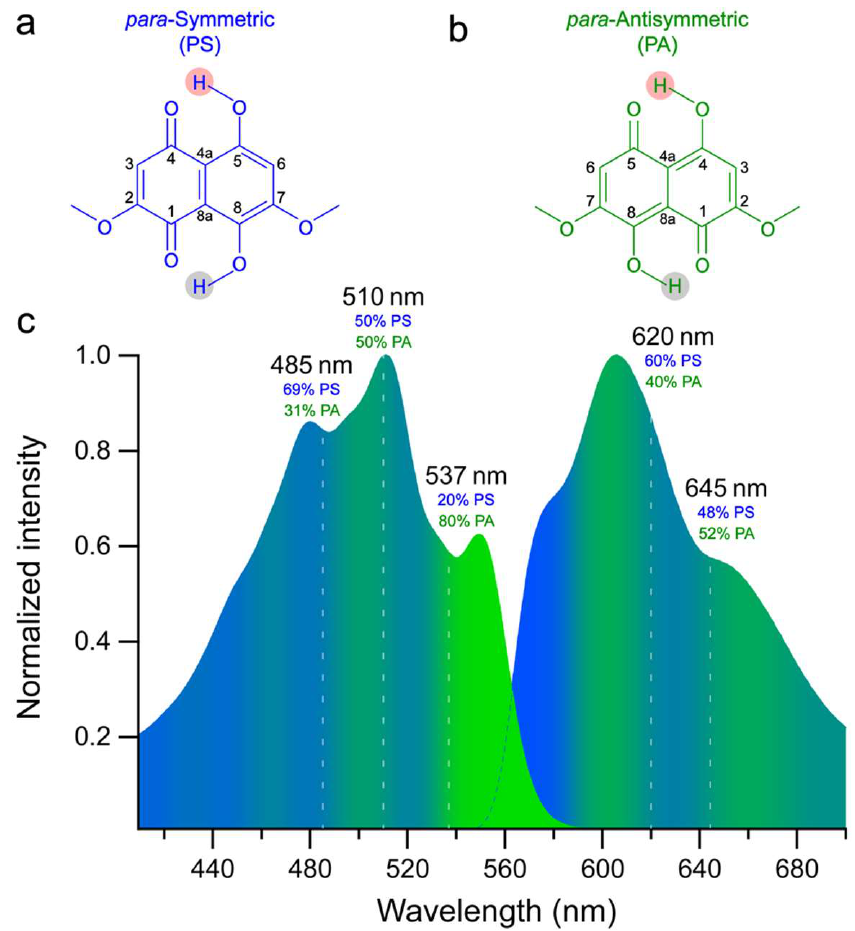
Figure 1. Structures of the two predominant tautomers of Draconin Red, dubbed para -symmetric or PS ( a ), and para -antisymmetric or PA ( b ). The protons that are proximal and distal to the methoxy sidechains are highlighted by semi-transparent gray and red circled shades, respectively. ( c ) The experimental steady-state electronic absorption and emission spectra of Draconin Red in DCM solvent are filled by colored shades at each wavelength according to an interpolated color scale of the calculated contribution from each tautomer, PS in blue and PA in green, with fine spectral features attributed to the vibronic bands. Vertical dashed lines indicate the experimentally relevant wavelengths for laser pulses used in fs-TA and FSRS measurements in this work, and the associated tautomer population percentages are listed nearby.